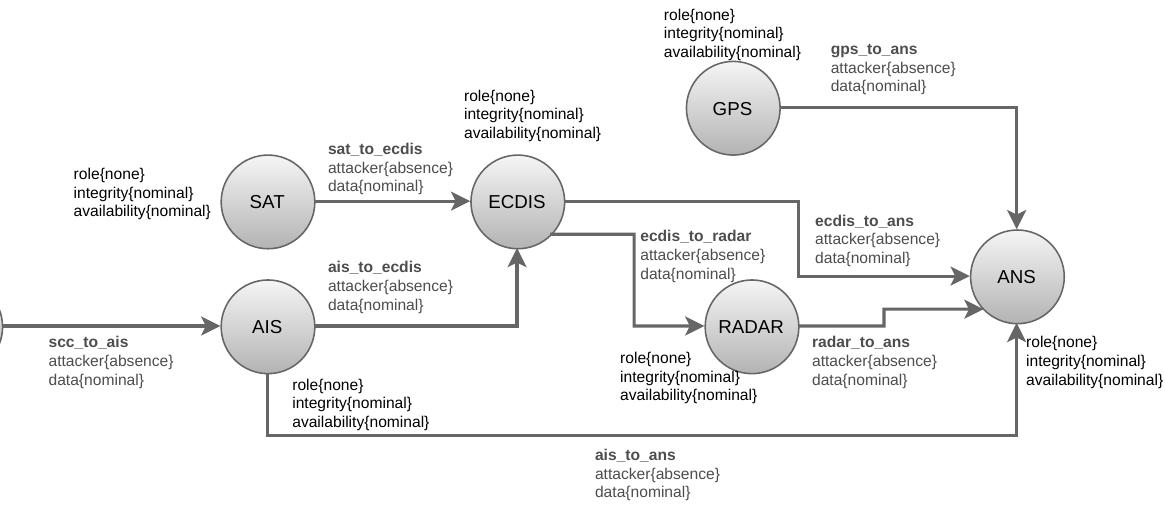
Figure 2. Illustration of the Autonomous Vessel Components and Communication Links with their